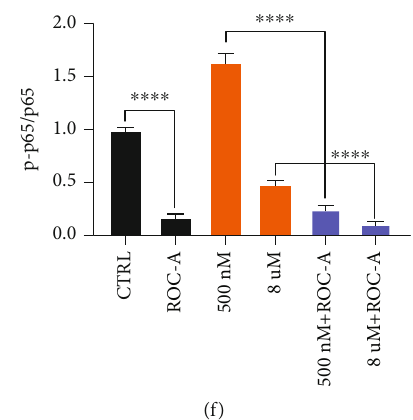
Figure 7: Dual e ff ects of Vericiguat on osteoclast di ff erentiation and bone resorption via a balance between VASP and NF- κ B. (a, b) The expression of NF- κ B protein in BMMs treated with Vericiguat only ( n = 3 ). ∗ indicated a comparison with the control group (Vericiguat, 0nM). (c) (A) The predicted optimal binding manner of Vericiguat at the ATP binding site of IKK β protein; hydrogen bonds (yellow lines). (B) MOLCAD representation showed the molecular lipophilic potential surface upon the bioactive pose of Vericiguat at the ATP binding site of IKK β . The blue represented hydrophilic, red represented lipophilic, and gray represented neutral moiety. Hydrogen bonds were displayed as yellow lines. (C) The overlap analysis of Vericiguat and the ligand of IKK β and the participating amino acid residue (Thr23) were marked. (d) TRAP staining of RANKL-induced BMMs treated with Vericiguat with or without the NF- κ B inhibitor ROC- A. (e, f) The expression of NF- κ B in RANKL-induced BMMs treated with Vericiguat with or without the NF- κ B inhibitor ROC-A. Scale bar = 500 μ m